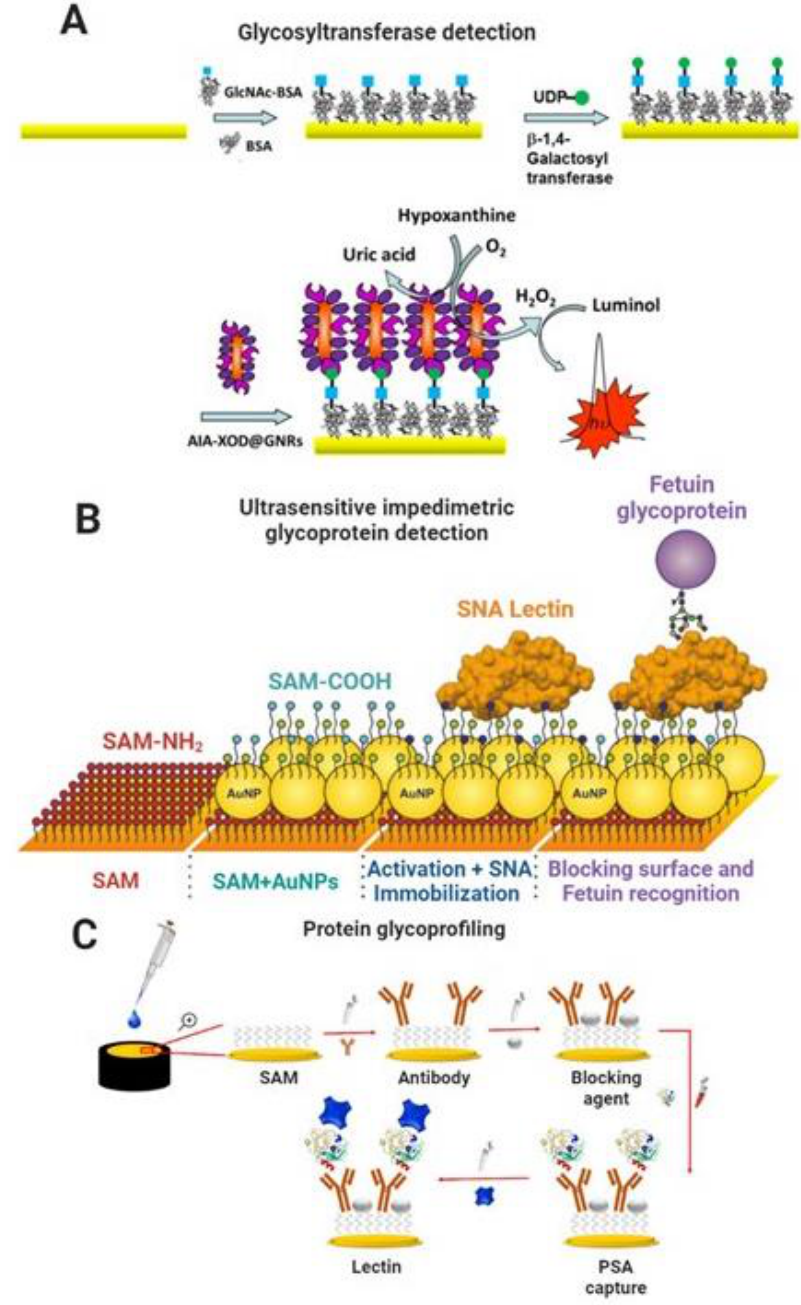
Figure 5. ( A ) Scheme of fabrication steps of biosensor based on a gold electrode modified with a bioconjugate of GlcNAc-BSA. Galactose transferred from UDP-Gal was specifically recognized by Ar- tocarpus integrifolia lectin (AIA) immobilized on gold nanorods (GNRs) conjugated to xanthine oxidase (XOD). Reproduced from [147] with permission. Copyright Elsevier 2016. ( B ) Scheme of biosensor construction steps (from left to right): formation of a linker layer (NH 2 -terminated alkanethiol-AT) on a gold surface (1st SAM on AuE); deposition of gold nanoparticles (AuNPs) and formation of a 2nd mixed SAM layer consisting of 11-mercaptoundecanoic acid and 6-mercaptohexanol on AuNPs; activation of the carboxyl group, subsequent covalent attachment of SNA I lectin, and finally an application of the lectin biosensor in the biorecognition of a glycoprotein, fetuin (FET). Adapted from [152] with permission. Copyright Elsevier 2013. ( C ) Scheme of construction steps of the biosen- sor for detecting PSA and glycoprofiling of PSA by application of lectin. Reproduced from [155] with permission. Copyright Elsevier